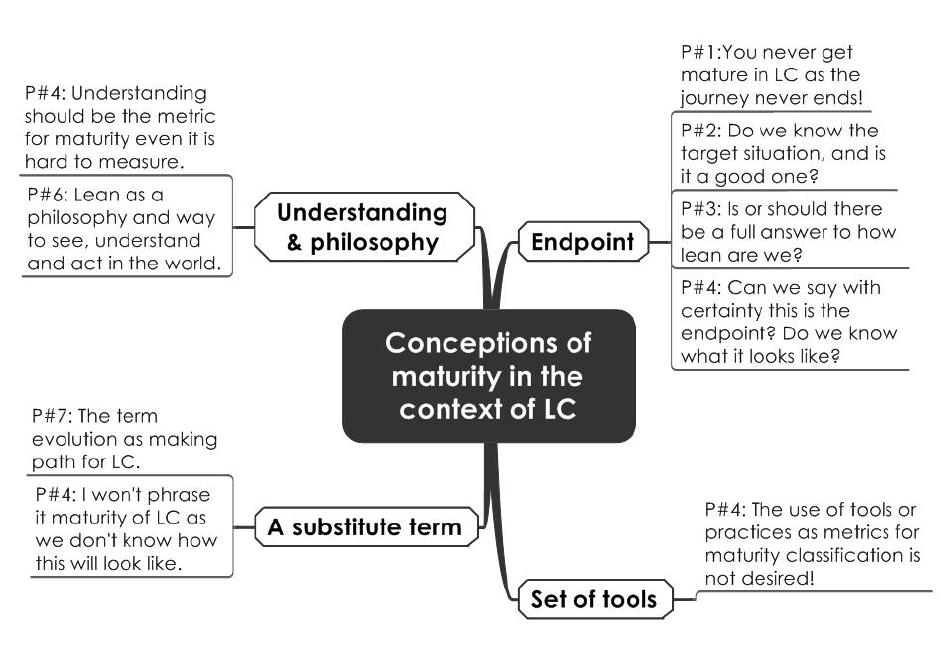
Figure 3 Conceptions of